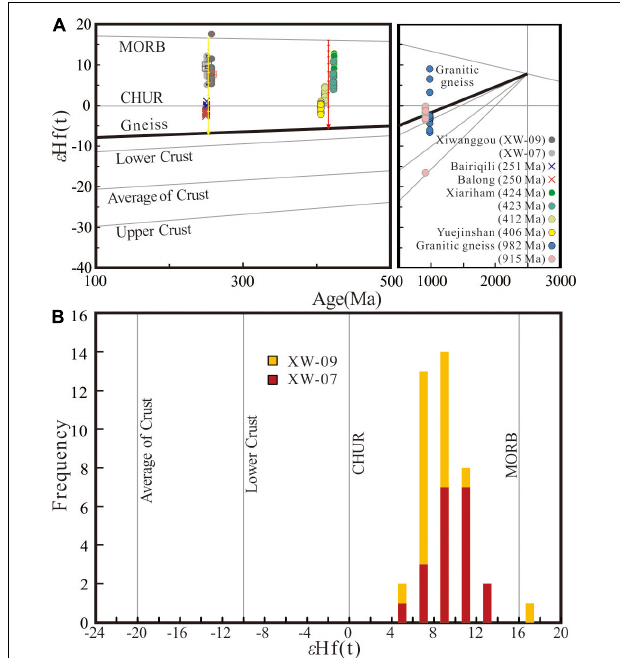
FIGURE 6 | (A) Zircon ε Hf( t ) value versus zircon U–Pb isotope age for the Xiwanggou mafic–ultramafic rocks. (B) The statistical histogram of zircon ε Hf( t ) values from the Xiwanggou complex. The Hf isotope evolution of the Precambrian granitic gneiss from East Kunlun orogen is calculated using the parameters for the upper crust given by Gan (2014) and He et al. (2016). The comparison of the late Silurian-Early Devonian mafic–ultramafic intrusions are based on the data from Xiarihamu and Yuejinshan areas (Liu et al., 2012; Wang et al., 2014; Li et al., 2015; Peng et al., 2016), and the Late Permian Bairiqili gabbro-diabase are based on Xiong et al.